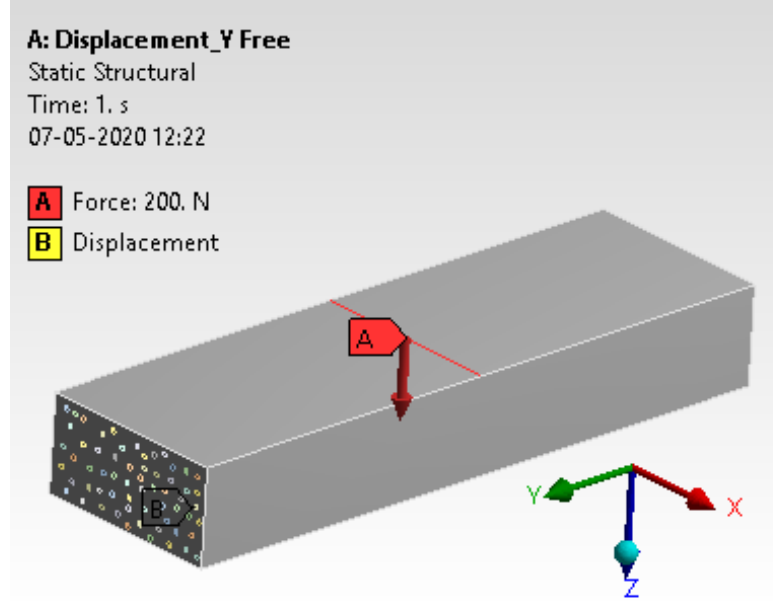
Figure 13. Loading details and boundary conditions.